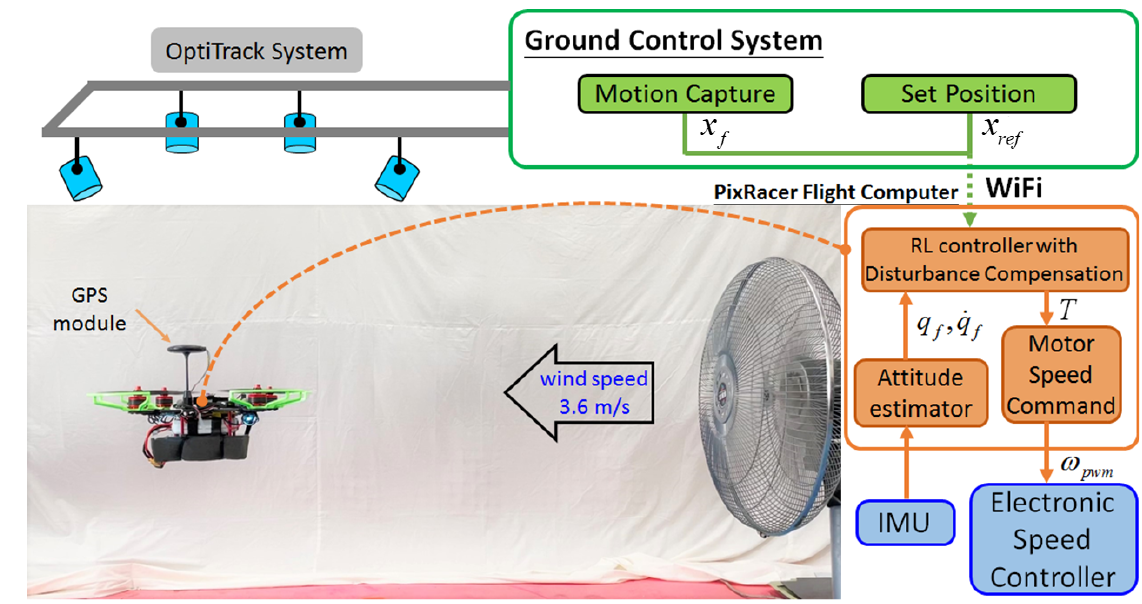
Figure 4. Experimental setup for indoor fixed-position hovering. An electric fan was used for simulating a constant wind disturbance with a speed of 3.6 m/s which was applied along the x -axis of the quadrotor.